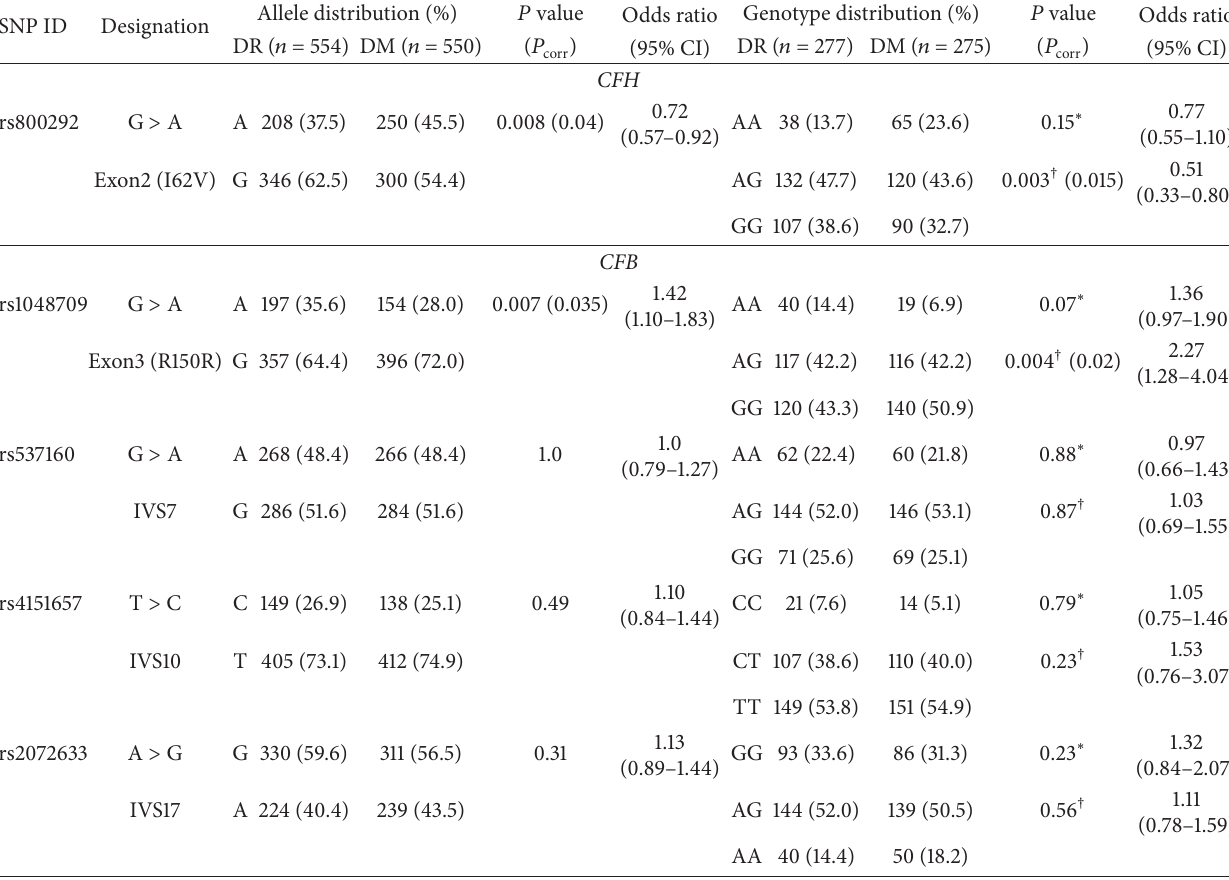
Table 2: Genotype and allele frequencies of CFH and CFB polymorphisms in DR patients and DM controls. SNP ID